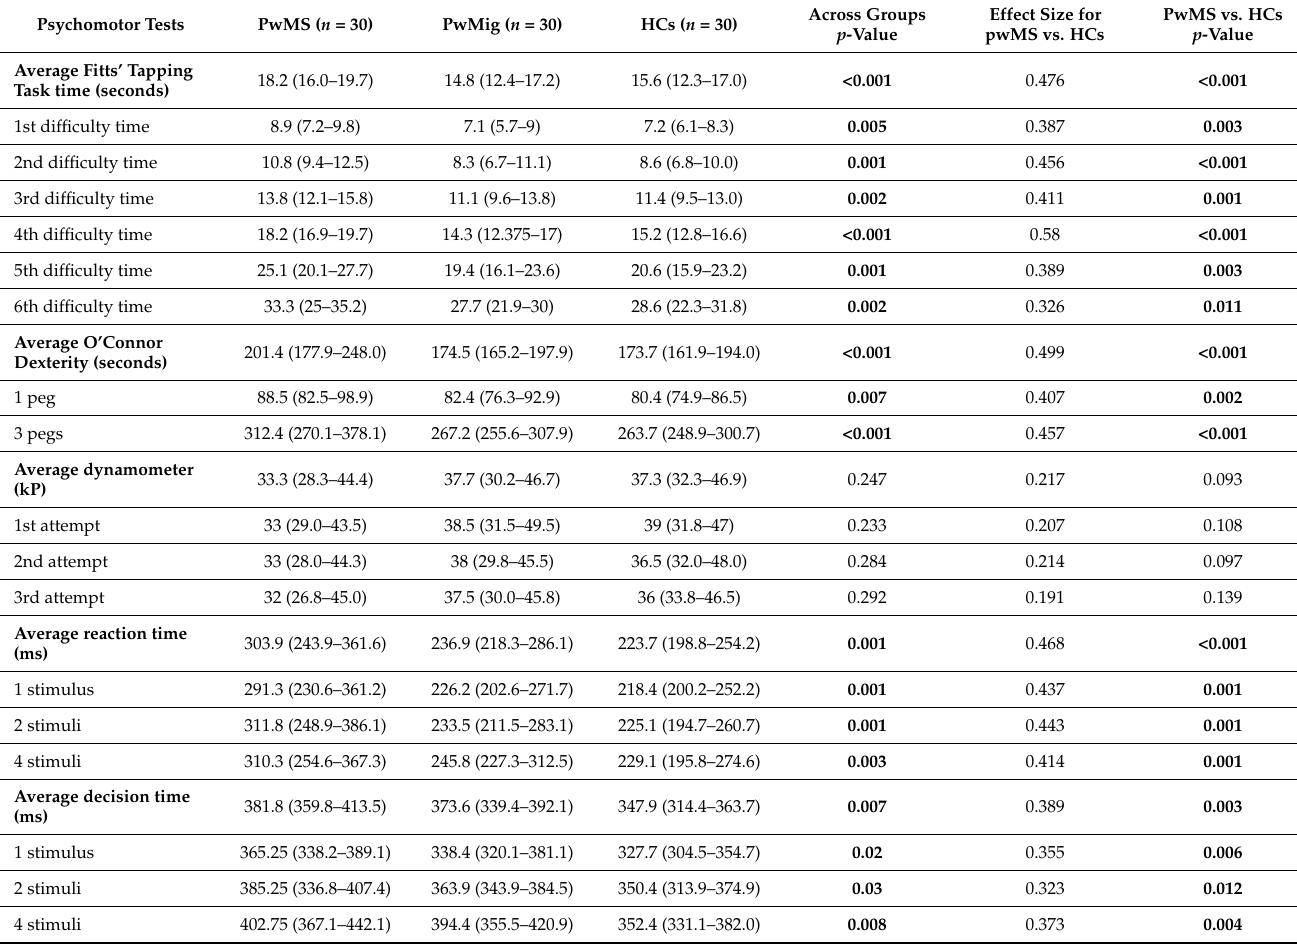
Table 4. Psychomotor performance in the study